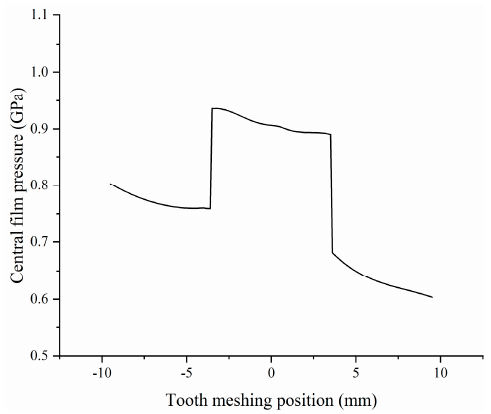
Figure 4. The variation of the central film pressure.